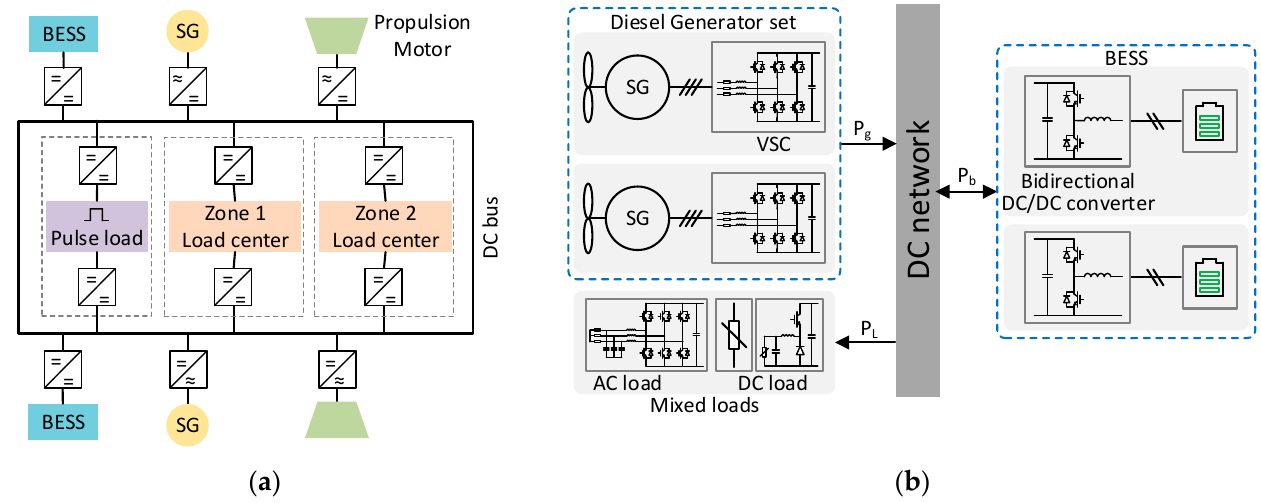
Figure 1. Configuration of a DC SMG: ( a ) typical configuration recommended by IEEE Std. 1709–2010; ( b ) simplified architecture of a DC SMG ( P g , P b , and P L are the output power from generators, charge/discharge power from BESS, and load power, respectively).